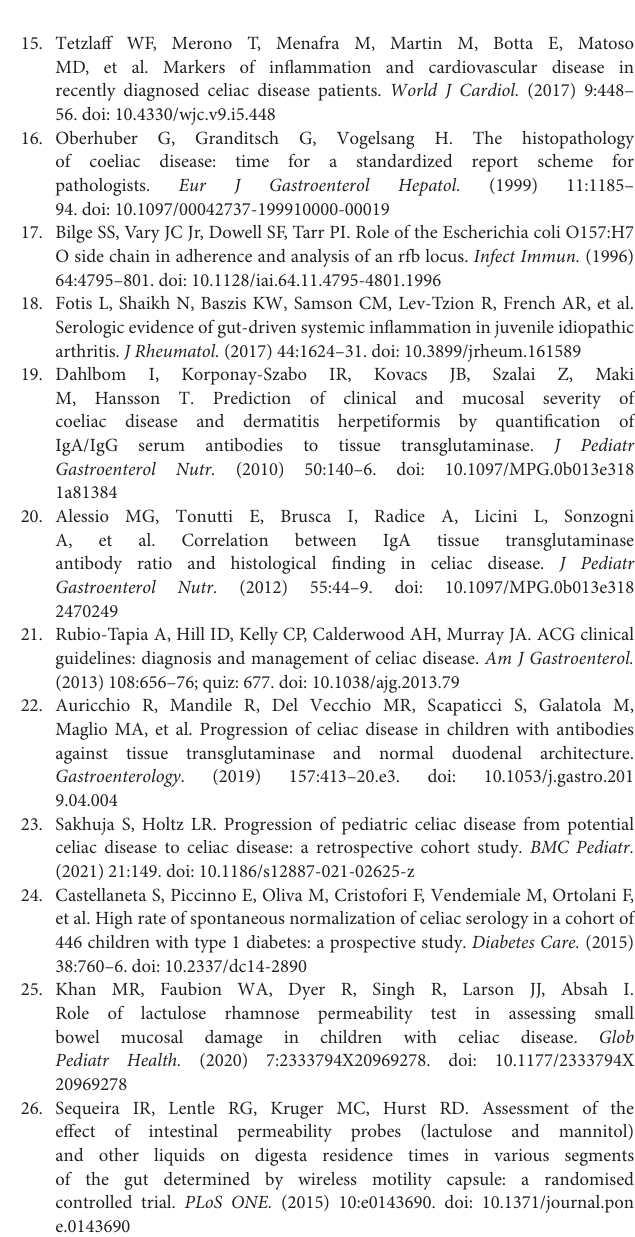
Supplementary Figure 2 | Dual sugar testing (baseline subtracted) compared to Marsh score in controls (C) and cases. P -values from Kruskal-Wallis. Horizontal lines represent medians and quartiles. (A) Controls and cases randomized to receive L:M. (B) Controls and cases randomized to L:R. Supplementary Figure 3 | Corrected L:M (adjusted M concentration based on the M clearance determined in the R group) compared to Marsh score controls (C) and cases. Horizontal lines represent medians and quartiles. P -values from Kruskal-Wallis. Supplementary Table 1 | TTG IgA and biopsy results in cases. Supplementary Table 2 | Additional serological testing in cases. Supplementary Table 3 | Characteristics of cases and